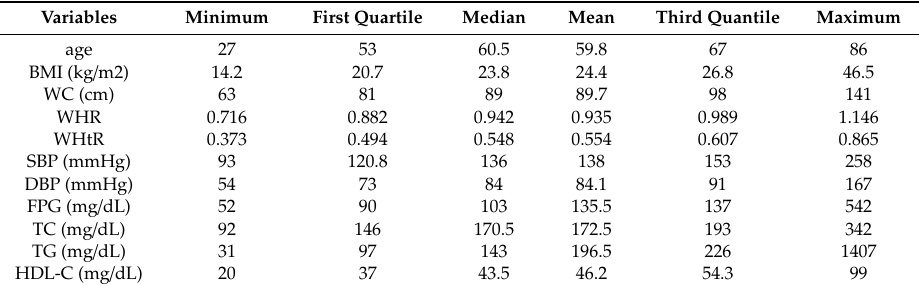
Table 1. Statistical description of continuous